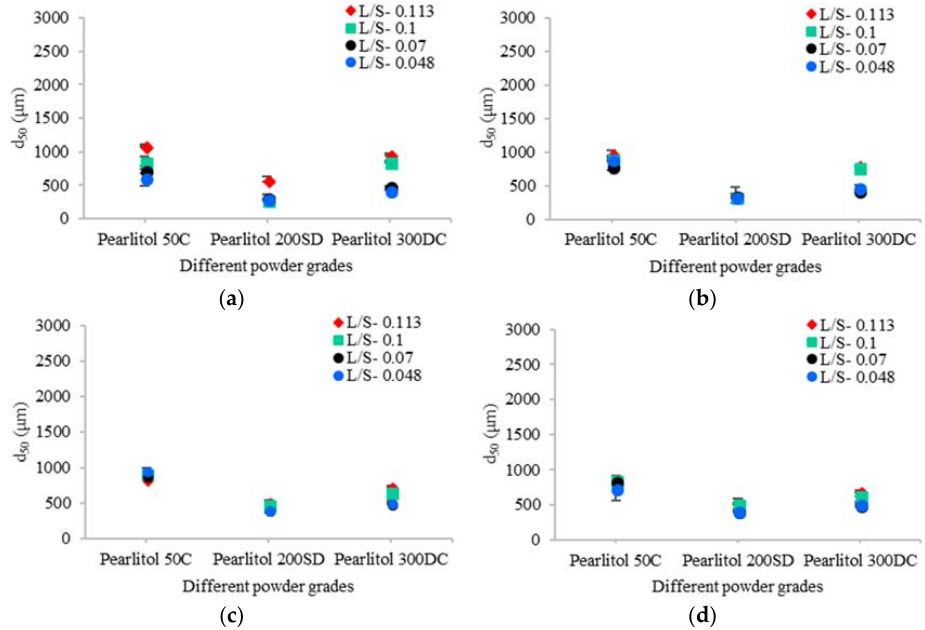
Figure 6. Median size of granules for different grades of mannitol powder at varying L/S and screw speeds. ( a ) 200 rpm; ( b ) 450 rpm; ( c ) 700 rpm; ( d ) 950 rpm.